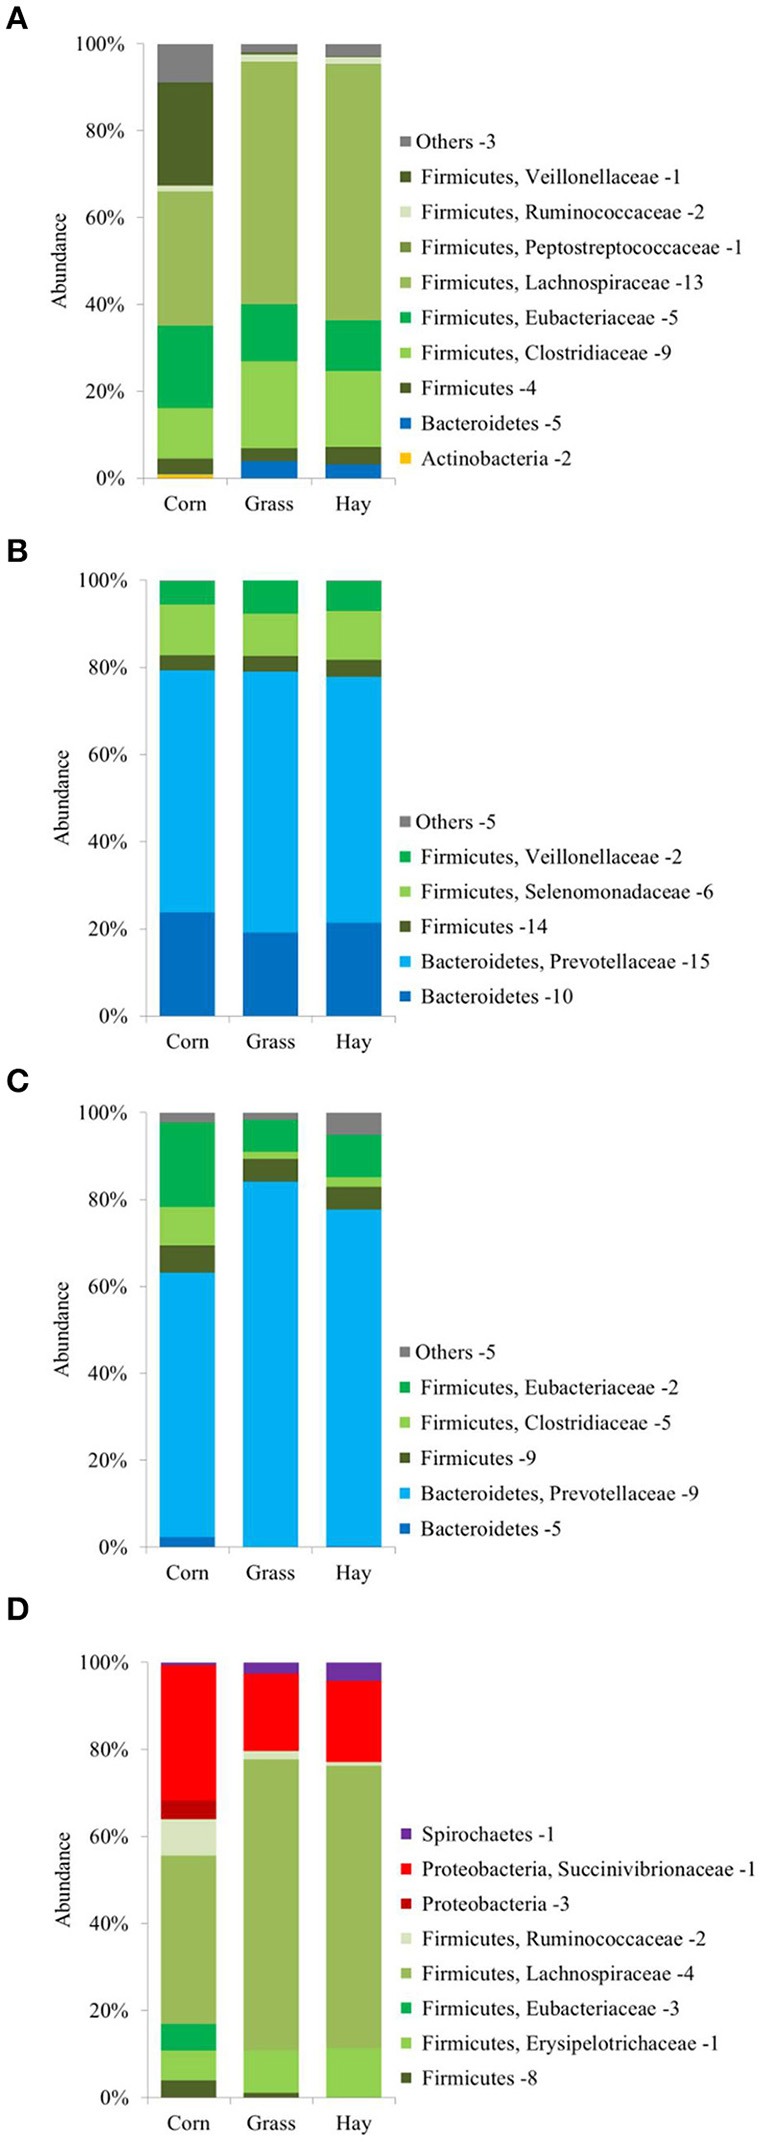
Average abundance and phylogenetic origin of bacterial enzymes involved in (A) butyrate, (B) propionate, (C) acetate, and (D) formic acid production in diets (n = 9). Numbers of assigned proteins are shown in the respective phylogenetic legends. For butyrate biosynthesis: COG4770 (acetyl/propionyl-CoA carboxylase), COG3426 (butyrate kinase), COG1250/COG1024 (3-hydroxyacyl-CoA dehydrogenase), COG0183 (acetyl-CoA acetyltransferase). For propionate biosynthesis: COG4799 (acetyl-CoA carboxylase), COG2185/COG1884 (methylmalonyl-CoA mutase). For acetate production: COG1012 (NAD-dependent aldehyde dehydrogenase), COG0282 (acetate kinase), COG0280 (phosphotransacetylase), and for formic acid COG1882 (formate acetyltransferase).